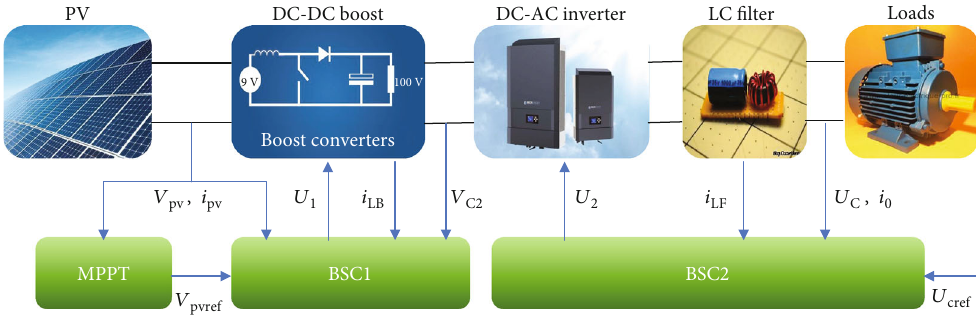
Figure 1: Block diagram of the proposed PV inverter system.